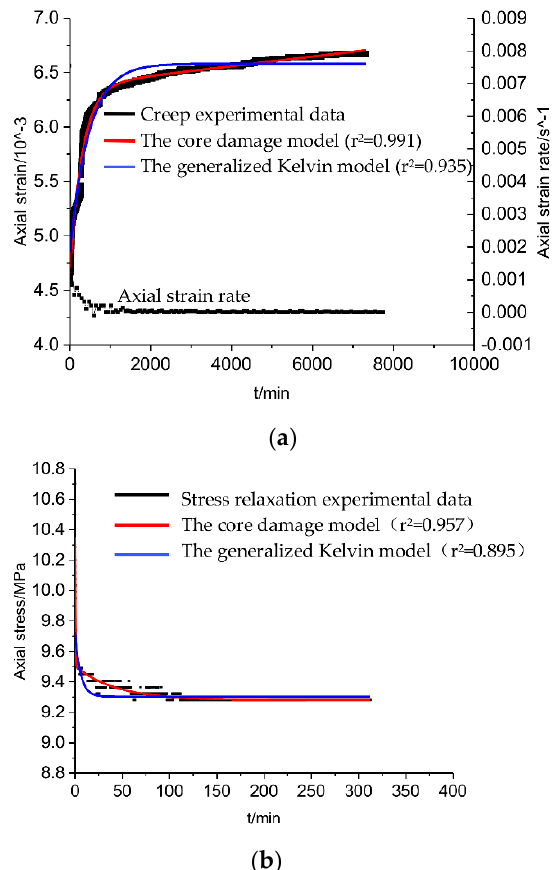
Figure 4. The generalized Kelvin model and the core damage model curves compared to the experi- mental data of lean coal. ( a ) Axial strain and rate of sample c-4 at the stress of 7.2 MPa, ( b ) Stress relaxation of sample r-4 at the strain of 1.2%.